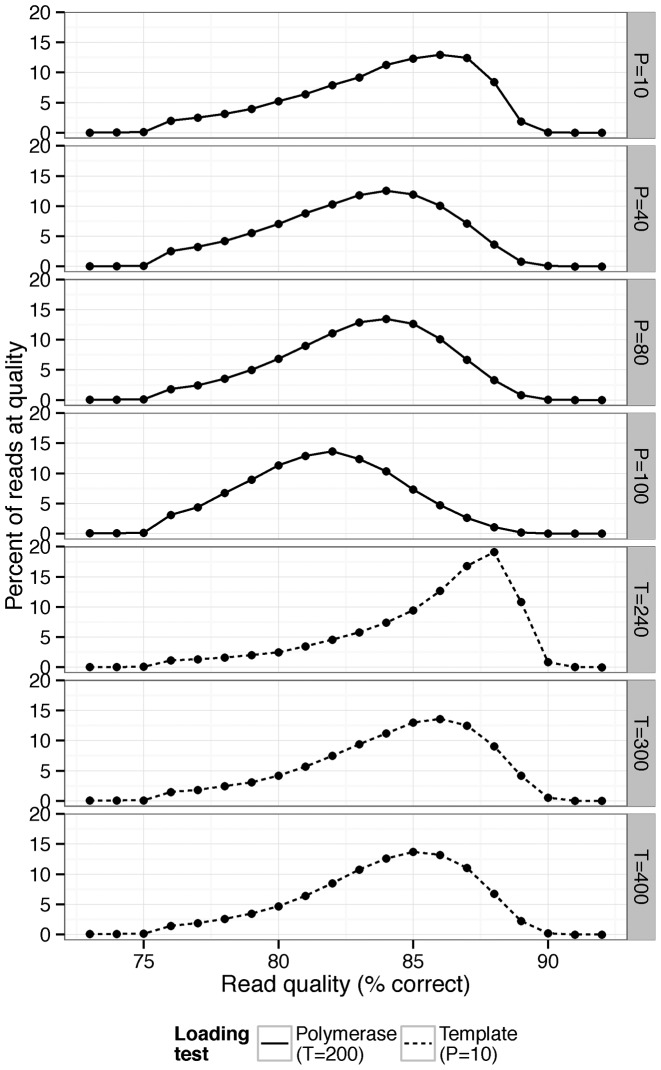
The distribution of read quality in sequencing runs performed at the UCI genomics core using our DNA preparation technique. ‘P’ here refers to polymerase loading during sequencing (the proportion of polymerase to template, where 10 would indicate a 10:1 ratio of polymerase to template), while ‘T’ refers to template loading concentration during sequencing (in picomolarity).